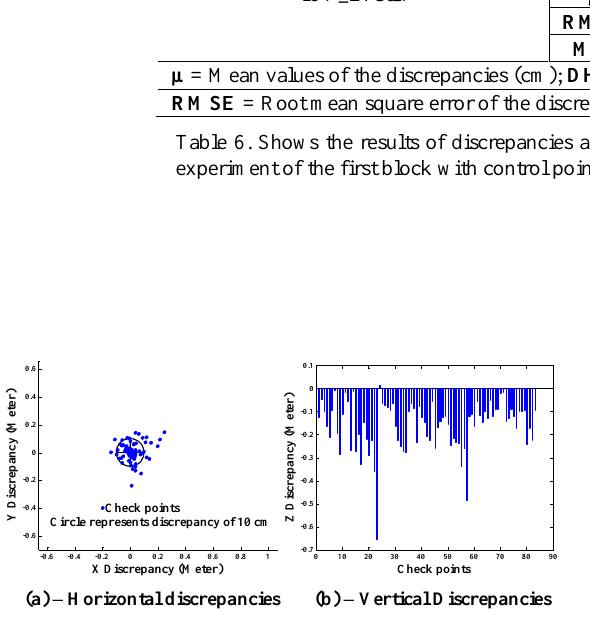
Figure 5. Horizontal e vertical discrepancies of check points (first block) from ISO experiment with control points and IOP from photogrammetric